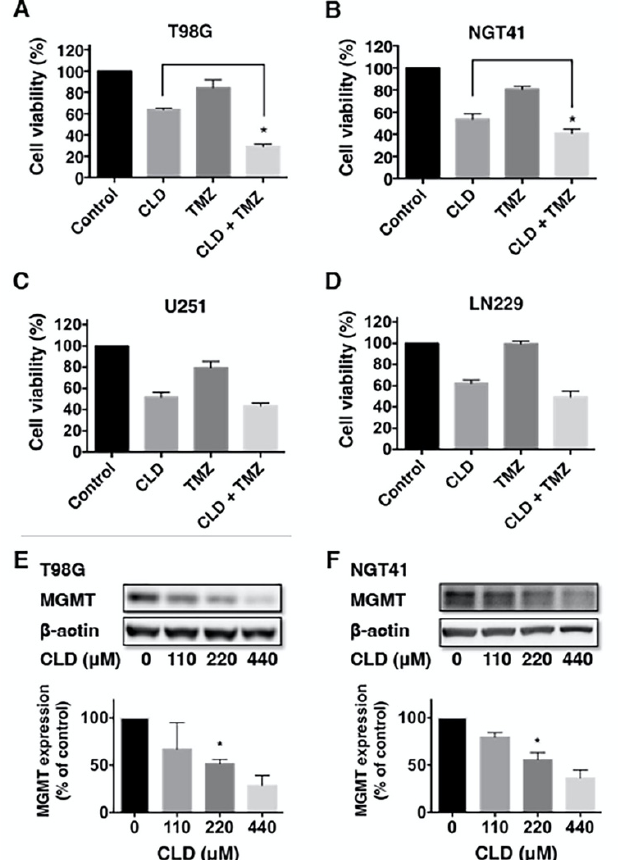
Figure 5. Effect of clindamycin and temozolomide combined treatment on glioblastoma cell viability. Combination effect of clindamycin (CLD) and temozolomide (TMZ) on glioblastoma cell viability ( A – D ). Cells were treated with a vehicle control, CLD (440 µ M), TMZ (125 µ M), or CLD (440 µ M) in combination with TMZ (125 µ M) for 72 h and subjected to a WST-1 cell viability assay. Data are presented as a percentage ratio to the vehicle control and are shown as the mean ± SE; similar results were representative of five independent experiments. The p -values were generated using a post hoc one-way ANOVA). The dose response of CLD (0, 110, 220, or 440 µ M) on the MGMT protein